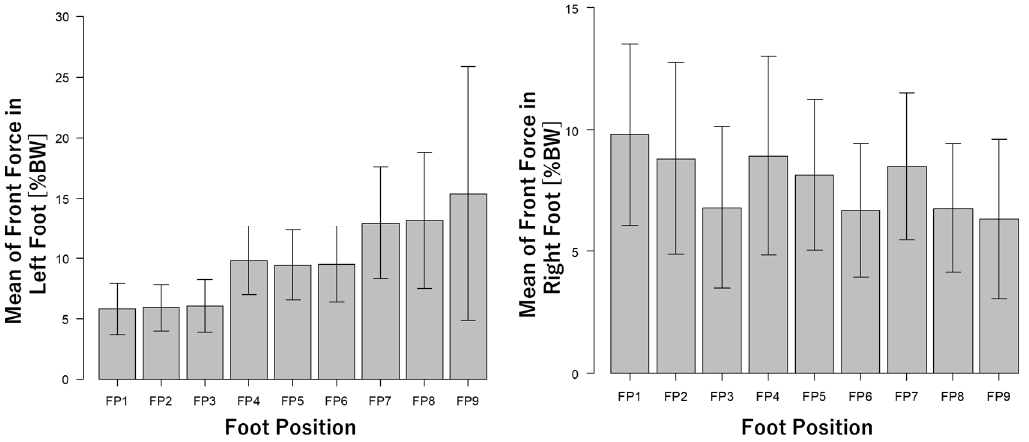
Figure 5. Mean of front force in left and right foot obtained from shoe-type force sensor. %BW is force normalized to the body weight of each participant. Values are mean ± standard deviations. FP: foot position.